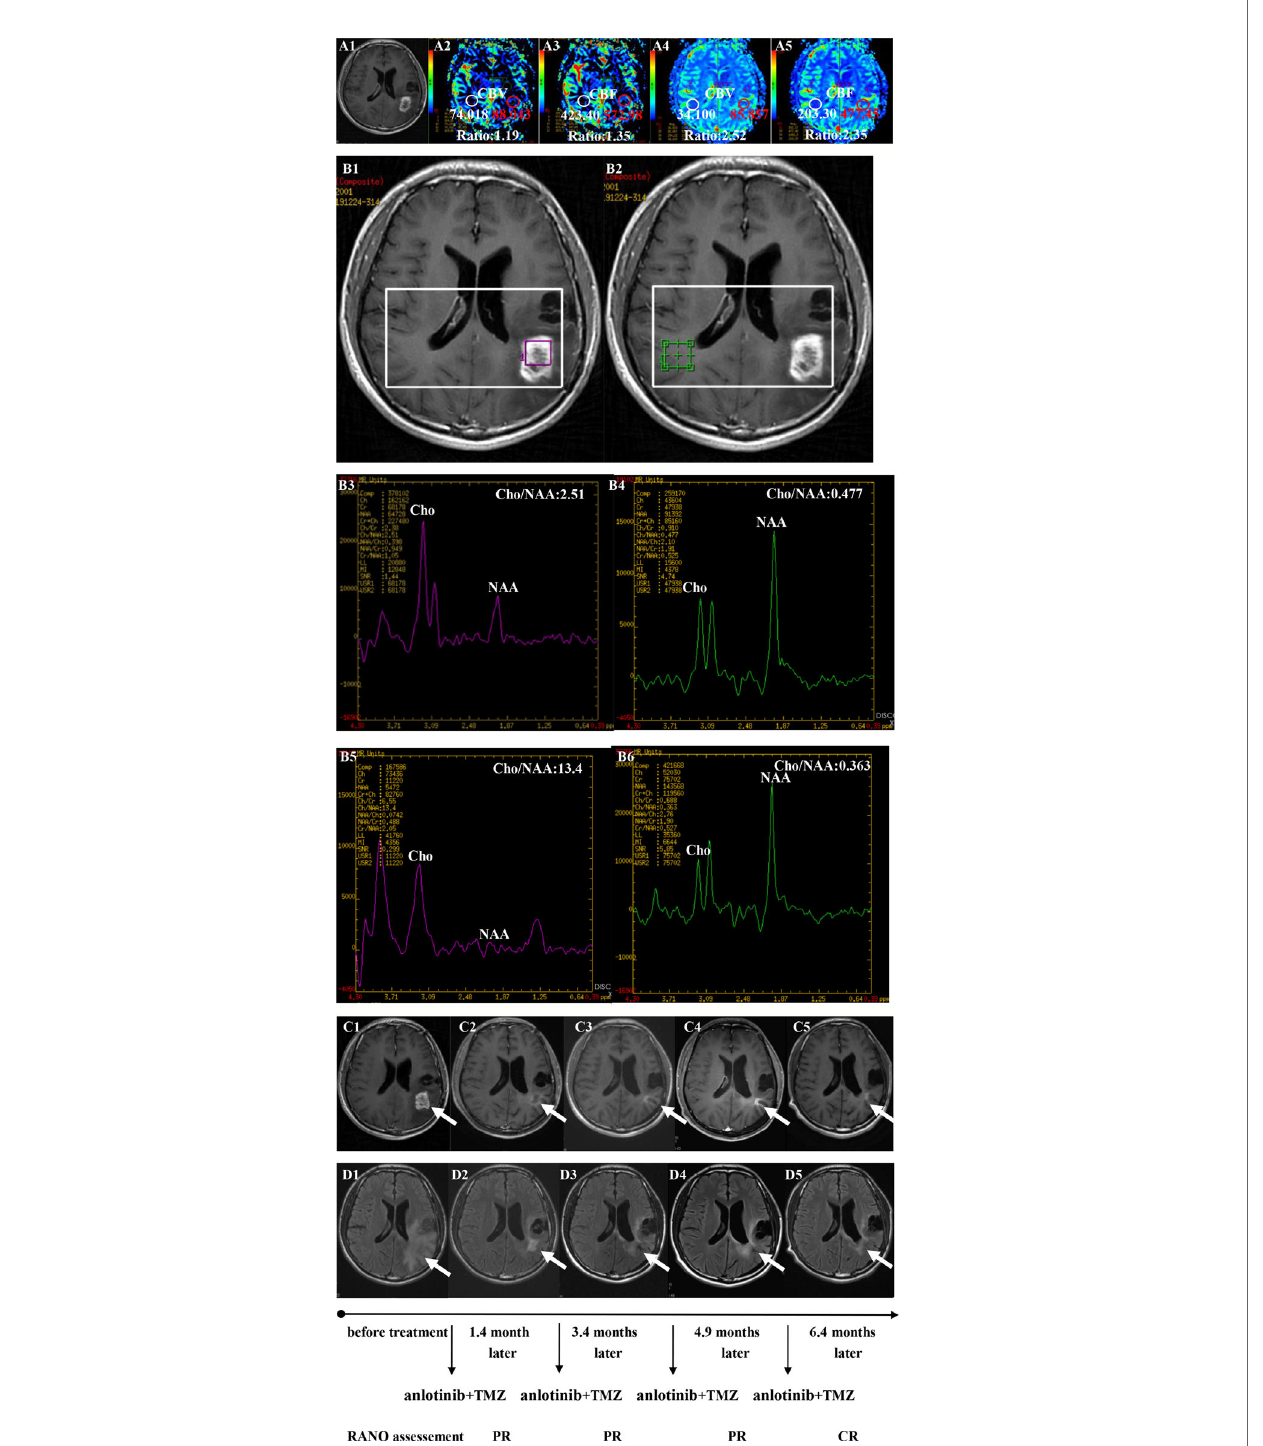
FIGURE 3 | Brain scan of patient number 5 (IDH1 − ; in situ recurrence. The interval time between the end of CCRT and the treatment of anlotinib combined with TMZ was 3.8 months). (A1 – A3) Perfusions maps at the time of suspected recurrence; (A4, A5) Perfusions maps at the time of diagnosis of recurrence 1.1months later, just watch and see, no additional therapy; (B1 – B4) MR spectroscopy (MRS) at the time of suspected recurrence; (B5, B6) MR spectroscopy (MRS) at the time of diagnosis of recurrence 1.1 months later, just watch and see, no additional therapy; (C1 – C5) Contrast-enhanced MRI; (D1 – D5) MRI-Flair; MRI images followed-up every 1 to 3 months before and after treatment. The arrow refers to the area of recurrence. The patient achieved complete remission after treatment and had a progression-free survival time of 16.8 months.